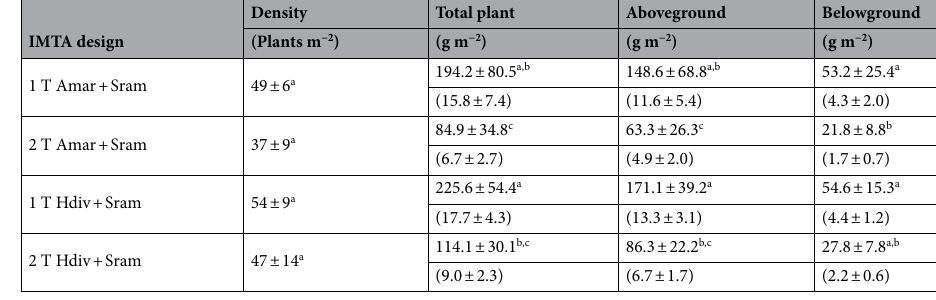
Table 3. Final density, total plant fresh weight biomass, aboveground and belowground fresh weight biomass of halophytes ( Salicornia ramosissima —Sram) cultured in the same tank (1 T) or in separate tanks (2 T) with polychaetes ( Arenicola marina —Amar—and Hediste diversicolor —Hdiv) at day 60. Average values ± SD (n = 5). Different letters indicate significant differences ( p < 0.05) between IMTA designs. The values between brackets indicate the dry weight biomass.